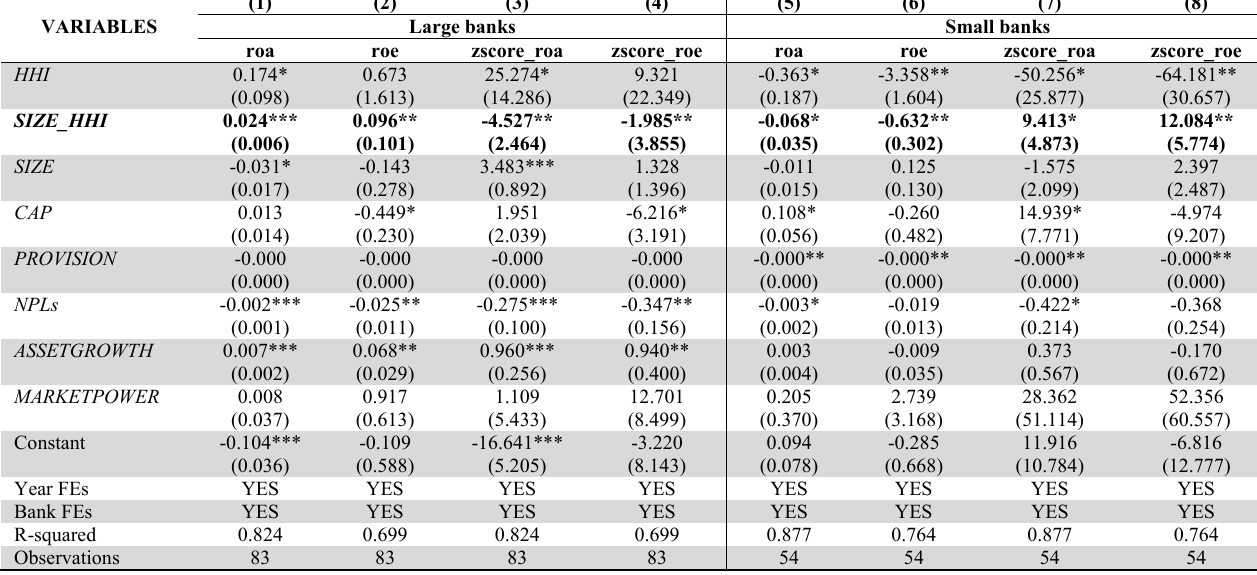
The impact of diversification on bank performance for large and small